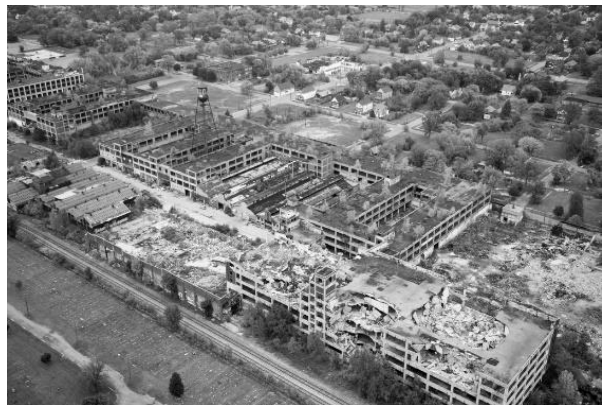
Figure 6. Packard plant, 1900, today. From: Detroit by Air, by Alex S. MacLean.